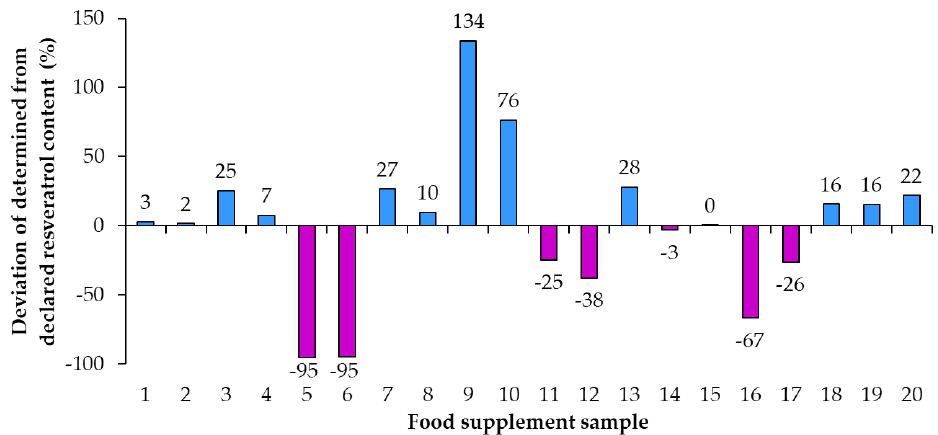
Figure 6. Deviation of determined content from declared content of resveratrol in food supplements.